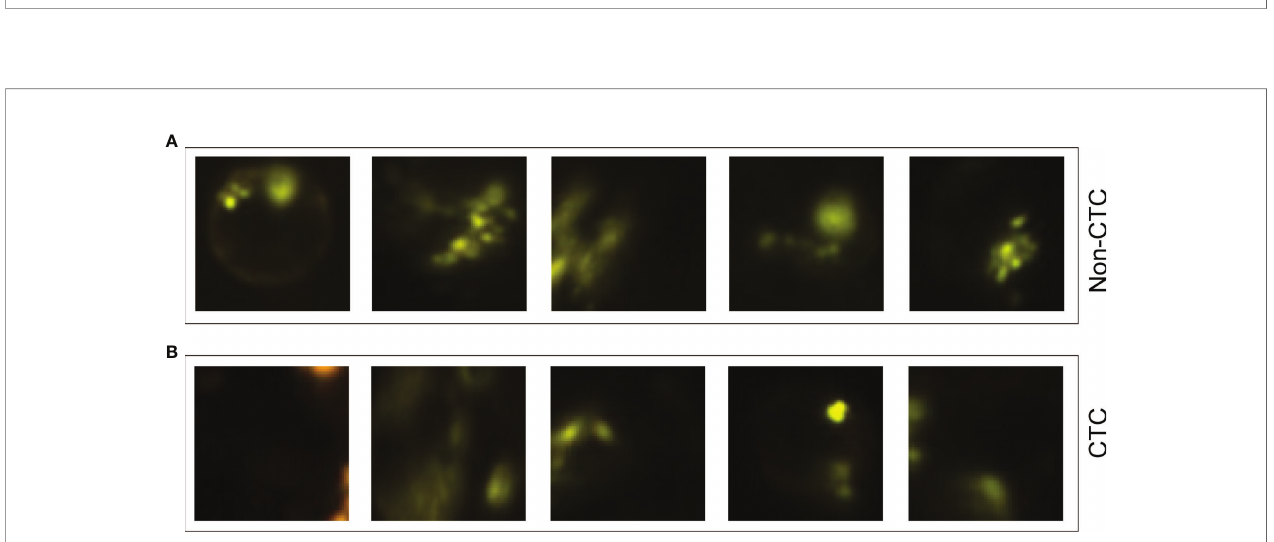
FIGURE 6 | Some misjudged images. (A) Non-CTC images, but they were identi fi ed as CTCs. (B) CTC images, but they were identi fi ed as